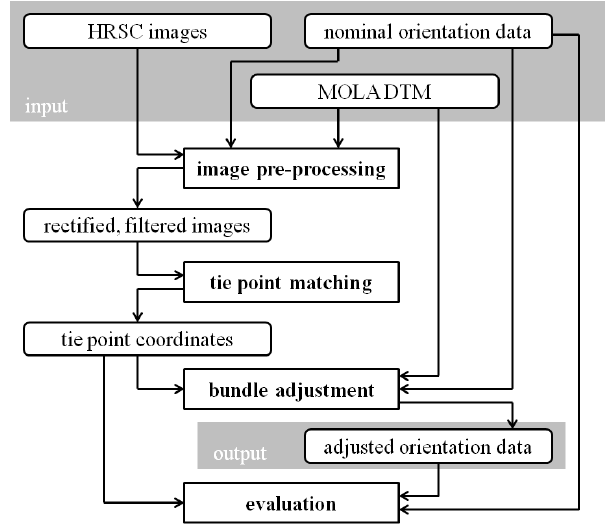
Figure 2: Workflow: Bundle adjustment of HRSC data Image pre-processing: After the reduction of image noise by a